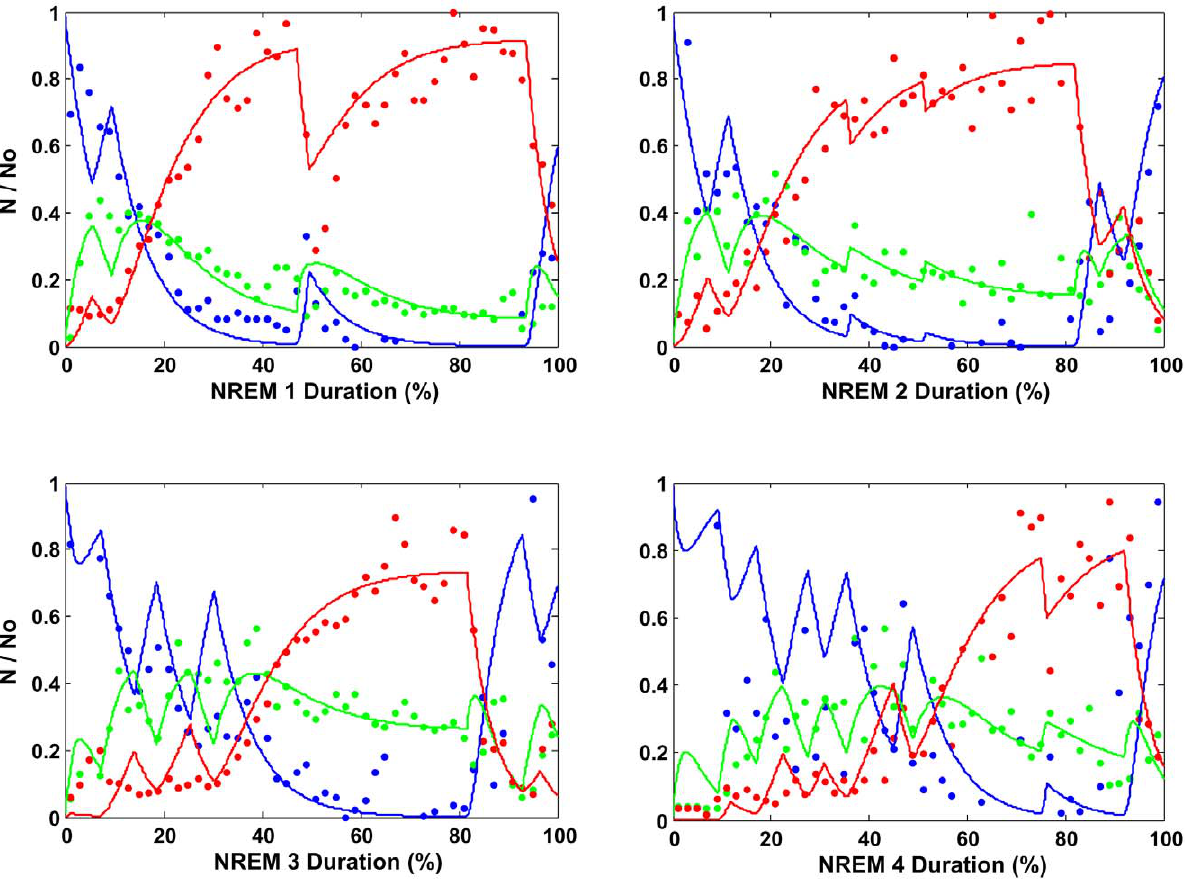
Figure 7. The NTP model fit to the data of representative NREM episodes 1 to 4. Data is represented by filled circles: beta (blue), sigma (green) and delta (red). The time scale is given as a percentage of the total duration of the given NREM episode. The number of neurons (N) in each mode beta, sigma and delta, is expressed as a percentage of the number of neurons in beta mode (N 0 ) at the start of the NREM episode. The model with the fixed probability set fits well all four NREM episodes: NREM 1 with 3 towards -and- away (TA) cycles: overall goodness of fit as measured by R 2 (%)=81.2, (R 2 delta=88.6, R 2 sigma=63.6, R 2 beta=84.7). NREM 2: 5 TA cycles; overall R 2 =75.5, (R 2 delta=89.2, R 2 sigma=48.6, R 2 beta=76.2). NREM 3: 5 TA cycles; overall R 2 =75.7, (R 2 delta=90.8, R 2 sigma=52.6, R 2 beta=70.3). NREM 4: 7 TA cycles; overall R 2 =63.1, (R 2 delta=86.2, R 2 sigma=46.1, R 2 beta=42.4).